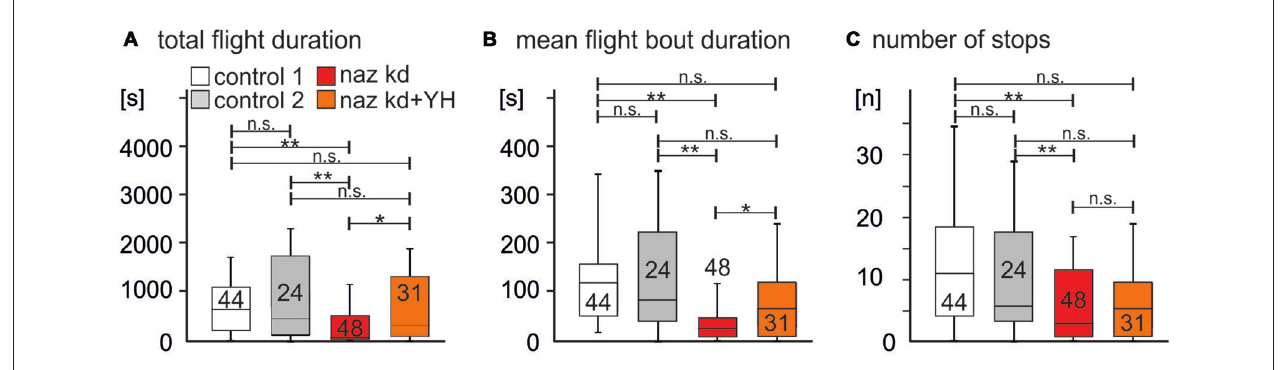
FIGURE 4 | Knock down of Naz reduces flight durations. (A) Total flight duration is significantly reduced in animals with knock down of Naz in Repo positive glial cells (Repo-GAL4 × UAS- naz -RNAi; UAS-Drc2, red bar; naz kd) as separately compared to two different controls (control 1, white bar; expression of UAS-drc2 under the control of Repo-GAL4; control 2, gray bar; expression of UAS-drc2 and UAS- naz -RNAi under the control of Mef2A). Total flight duration of animals with knock down of Naz in Repo positive glial cells is significantly increased by feeding of the TAR blocker Yohimbine (YH; naz kd + YH, orange bar). Feeding YH to animals with naz-RNAi knock down yields flight durations that are not significantly different from those of control 1 or of control 2. (B) Similarly, mean flight bout duration is significantly reduced in animals with knock down of Naz in Repo positive glial cells as compared to each control, and this phenotype if also rescued by feeding of YH. (C) The number of flight bouts is also significantly reduced in animals with knock down of Naz in Repo positive glial cells as compared to each control. Feeding of YH increase the mean of flight bouts slightly but not significantly. Kruskal Wallis ANOVA with Dunn’s post hoc testing, ∗∗ p < 0.01, ∗ p < 0.05, n.s. p >